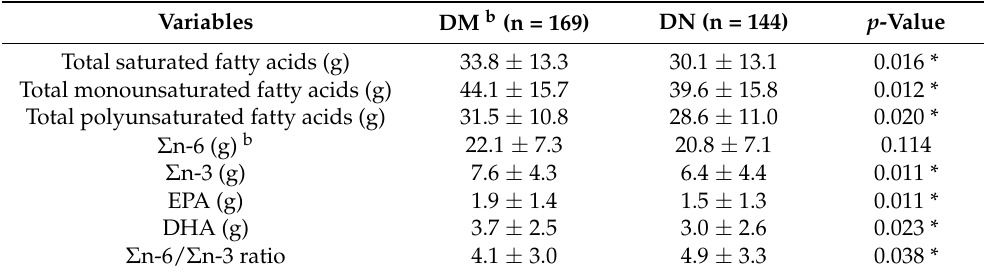
Table 4. Dietary fatty acid consumption of participants. a